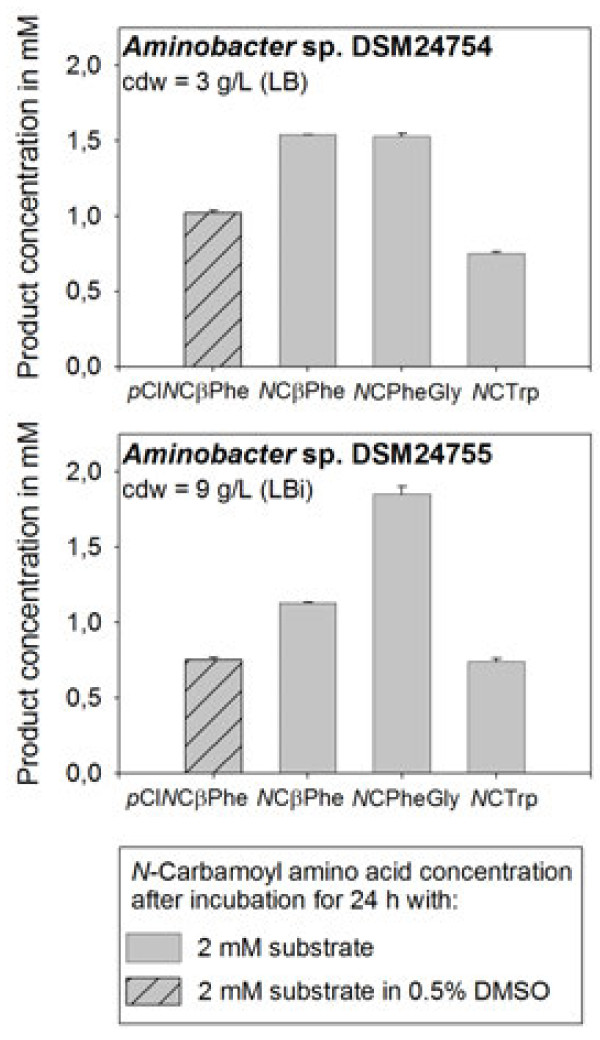
Product concentrations measured after 24 h of resting cell biotransformation experiments with Aminobacter sp. DSM24754 compared to the results determined for Aminobacter sp. DSM24755 with four different substrates: para-Chloro-phenyldihydrouracil (pClPheDU) is converted to para-chloro-N-carbamoyl-β-phenylalanine (pClNCβPhe), phenyldihydrouracil (PheDU) is converted to N-carbamoyl-β-phenylalanine (NCβPhe); phenylhydantoin (PheHyd) is converted to N-carbamoyl-α-phenylglycine (NCPheGly) and indolymethyl hydantoin (IMH) is converted to N-carbamoyl-α-tryptophan (NCTrp). The substrate concentrations were 2 mM; cdw = cell dry weight.